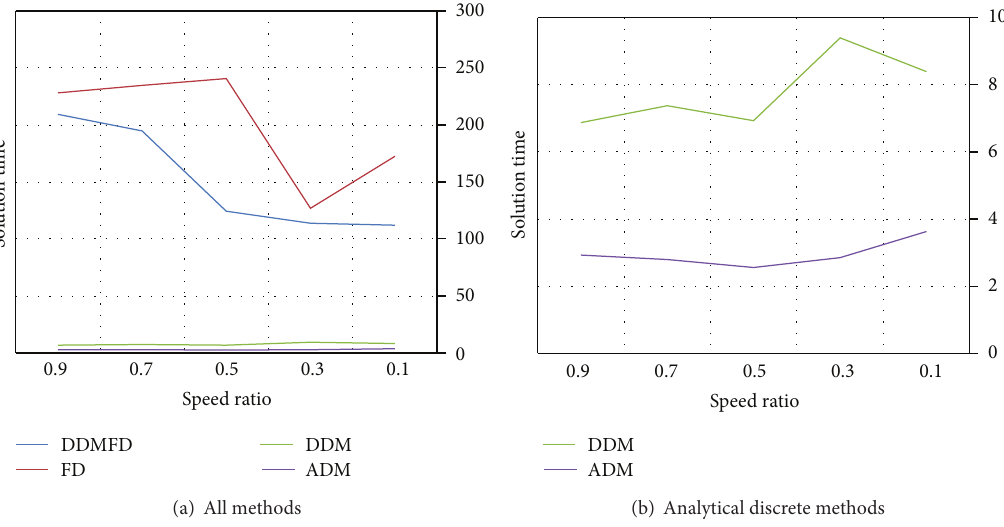
Figure 11: Comparison of solution time between different sensitivity methods.